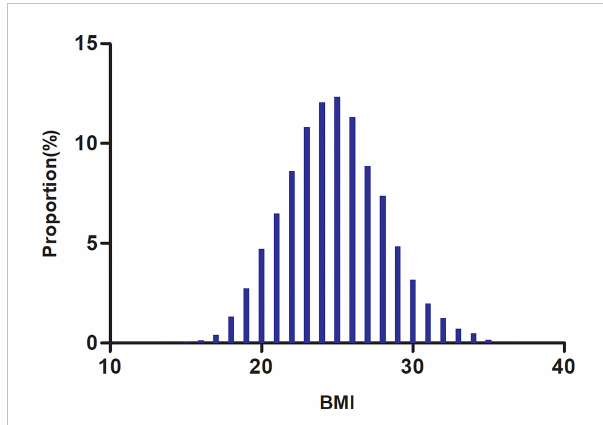
FIGURE 2 Distribution of BMI. It presented a normal distribution, ranging from 15.2 to 34.9kg/m 2 , with a mean of 24.74kg/m 2